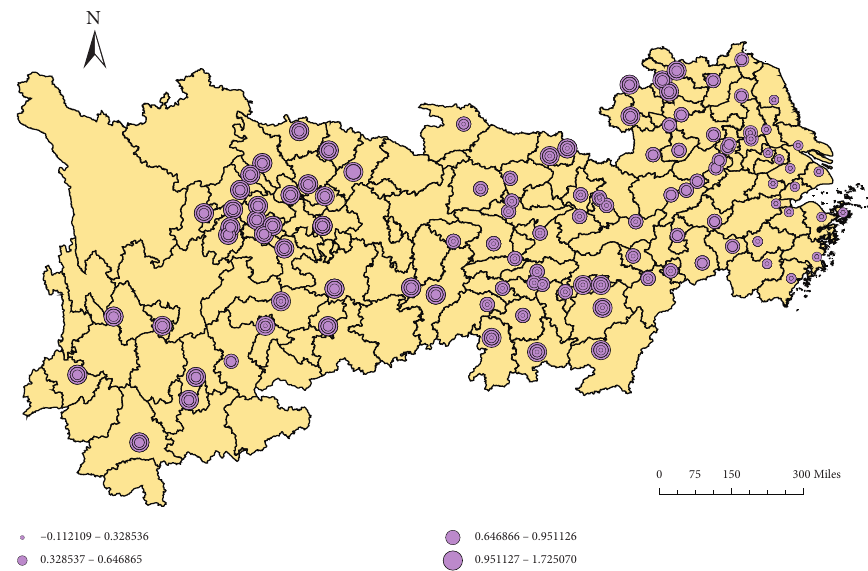
Figure 3: Spatiotemporal distribution of secondary